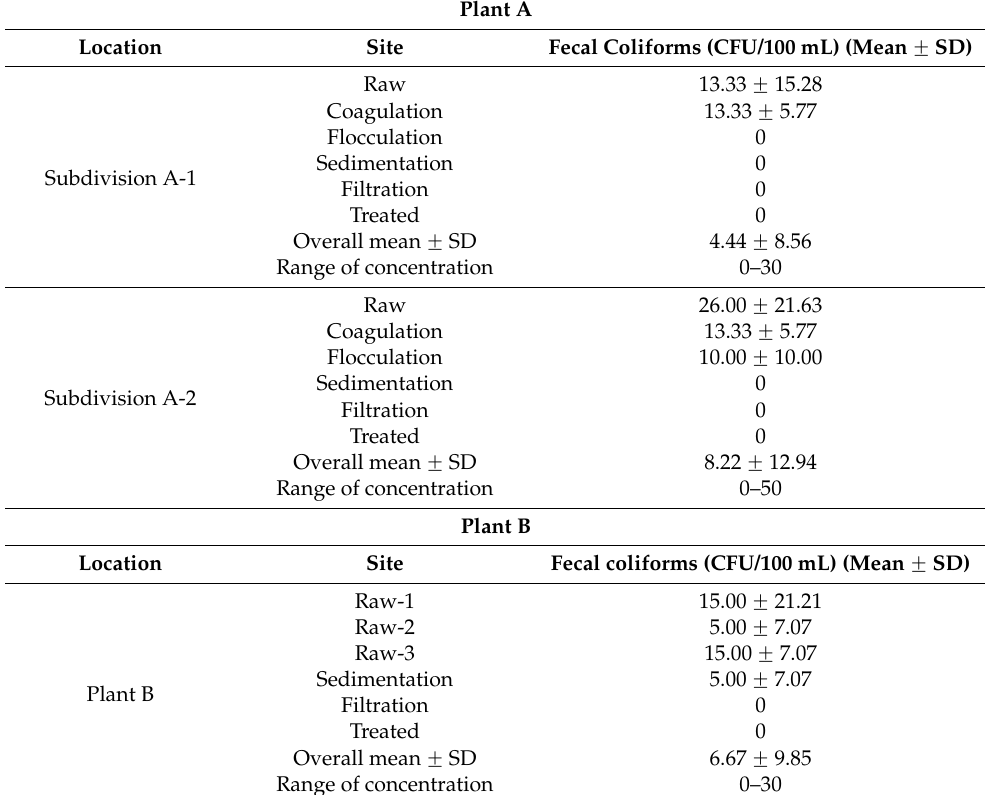
Table 3. Concentration of fecal coliform counts at various processing sites in each treatment